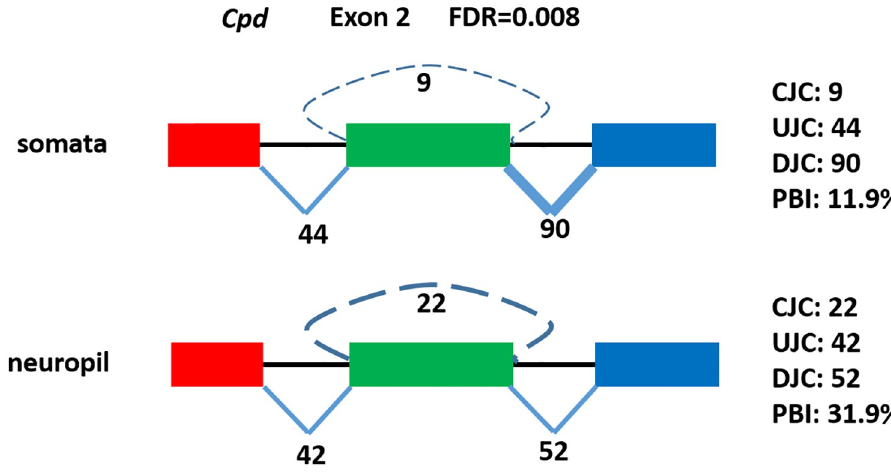
Fig 5. An example of differentially expressed circRNA (green exon). Its ratio of circRNA to linear RNA (PBI) is higher in neuropil sample than in somata